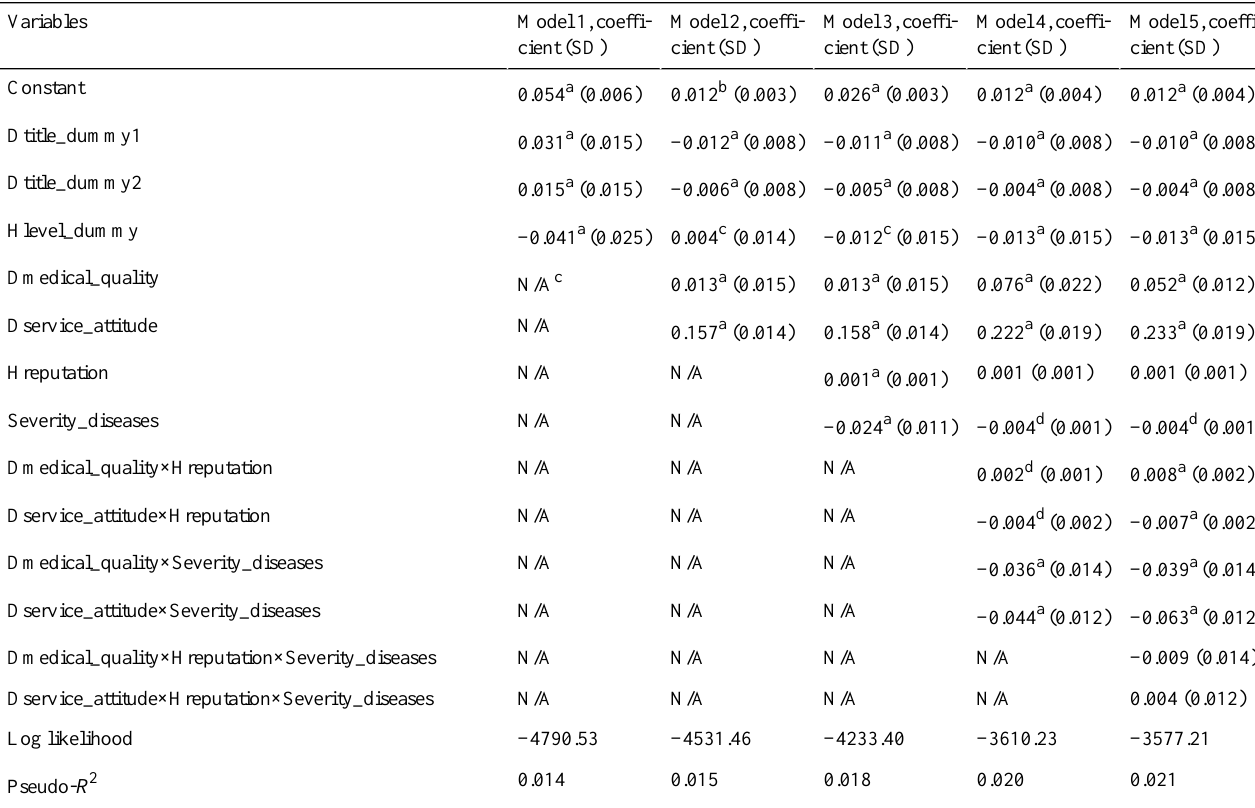
Table 3. Results for the patient propensity to post treatment experiences. General linear model regression was used to obtain results.